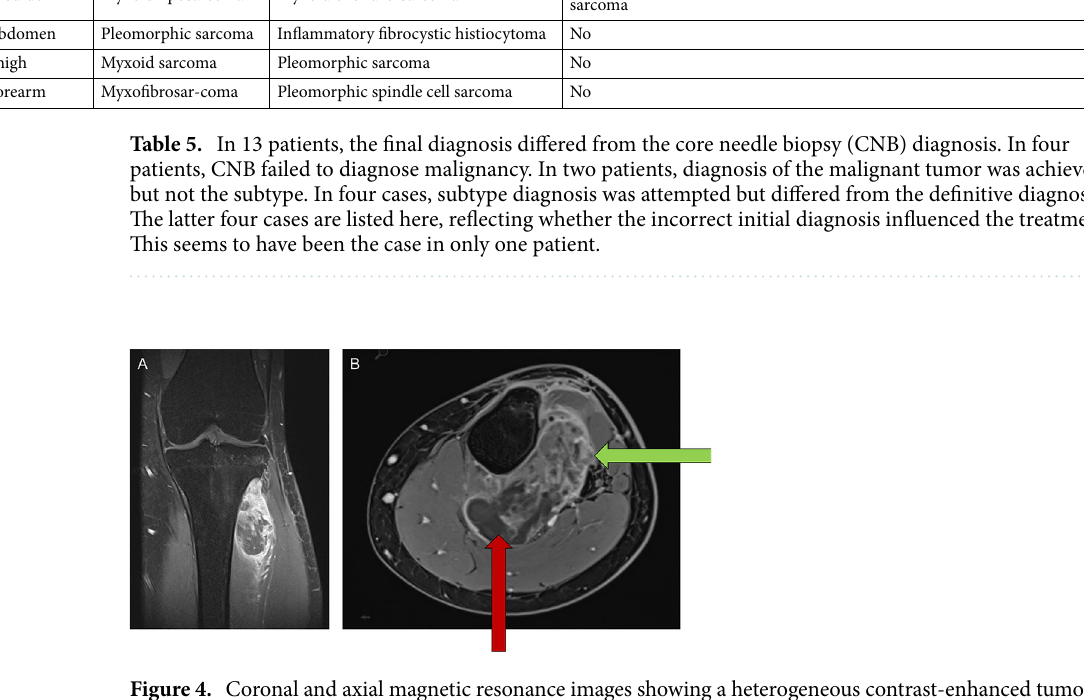
Figure 4. Coronal and axial magnetic resonance images showing a heterogeneous contrast-enhanced tumor of the leg in a 19-year-old girl. Two percutaneous CNB from the posterior region of the tumor were performed (red arrow in B ) because the ventral part of the tumor had a close relationship to the peroneal nerve. Both biopsies resulted in inconclusive pathology. An open biopsy was required from a more contrast-enhancing ventral region (green arrow in B ) to diagnose extraskeletal Ewing’s sarcoma. The estimated delay to diagnosis from the two failed CNBs, in this case, was two and a half weeks. This case illustrates the importance